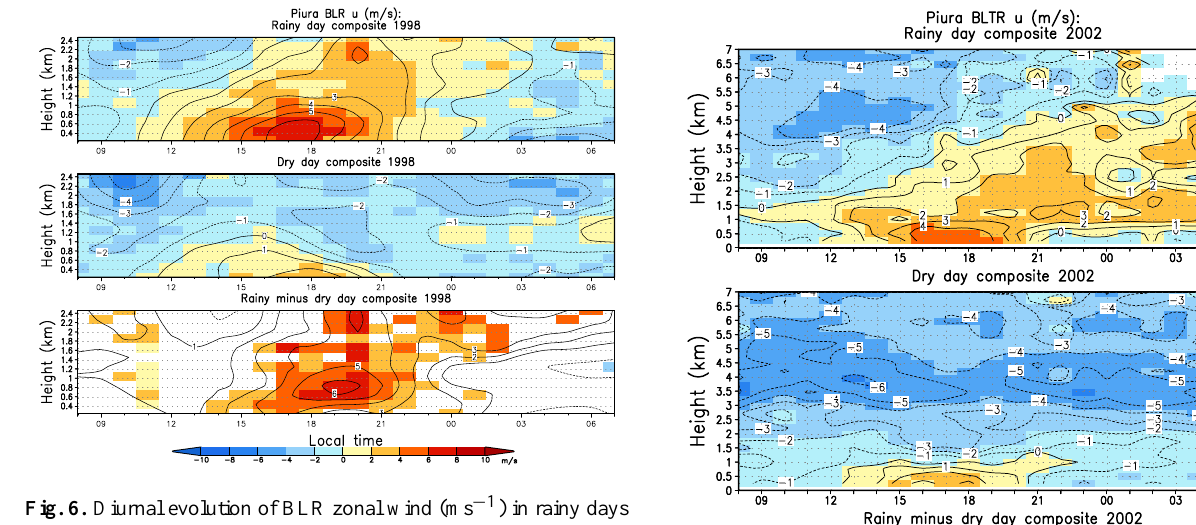
Fig. 6. Diurnal evolution of BLR zonal wind (ms − 1 ) in rainy days (top) and dry days (middle) and the difference between the two (bot- tom) in the period January 1997 to April 1998. Only differences that pass a Student- t test at the 95% level are shaded.